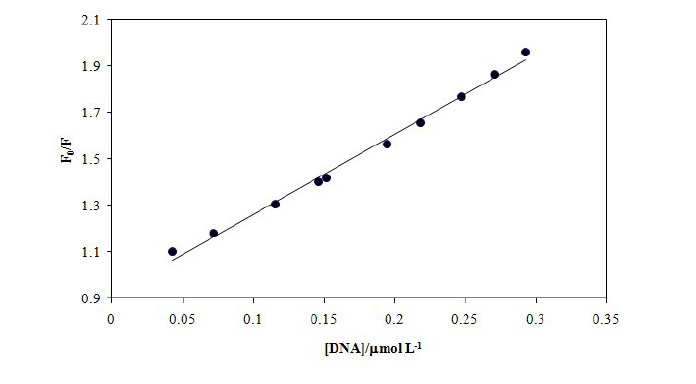
＝ 50.0 μmol L -1 in EPR